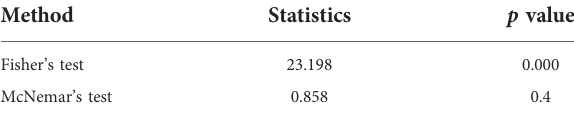
TABLE 4 Correlation and difference analysis of two diagnostic methods based on the cut-off values of ROI 21 CTh and ROI 14 HU value for